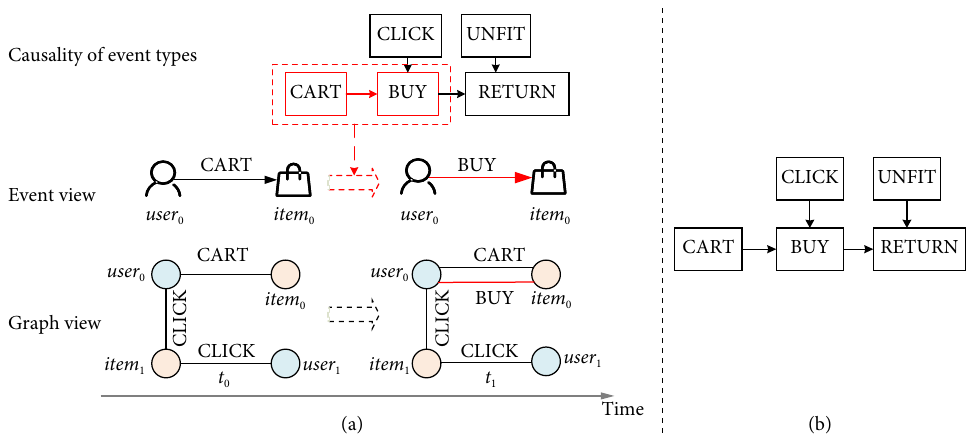
Fig. 1 (a) Sample of a dynamic heterogeneous graph. An event represents an edge of the graph. Some events occurring in the original graph are emphasized in the event view. The event type BUY represents that the user purchases this item, and the event type CART represents that the user adds this item to the shopping cart. The user 0 adds item 0 to the shopping cart at time t 0 , and purchases it at time t 1 , implying that BUY is possibly the result of CART. (b) A sample of HCG. This HCG comprises five vertexes and four links. Each link represents a causal relationship and its head and tail represent cause and effect,